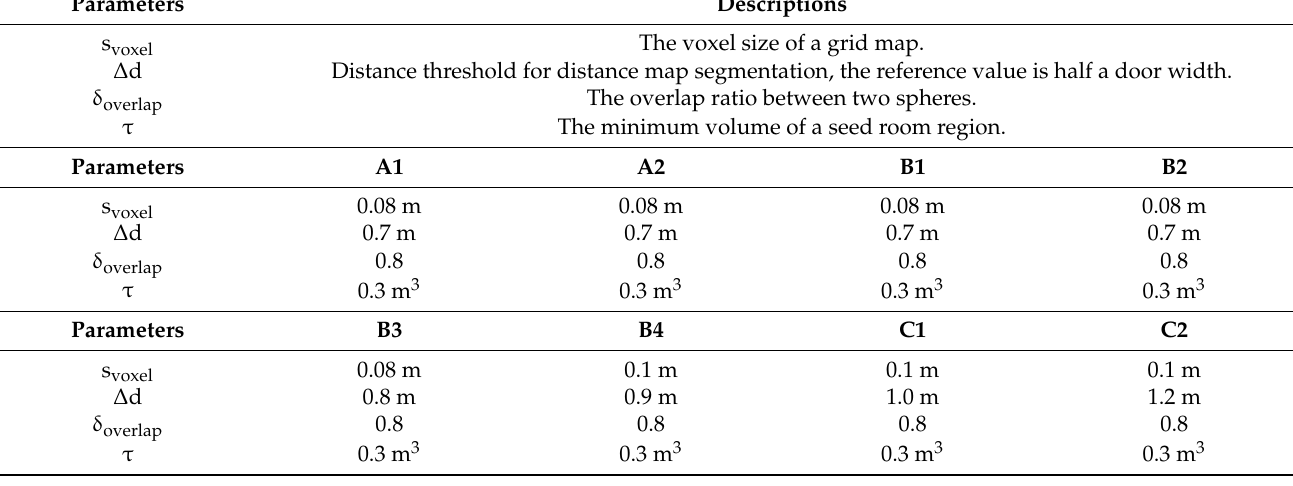
Table 2. Parameters and descriptions of the proposed method for different datasets.